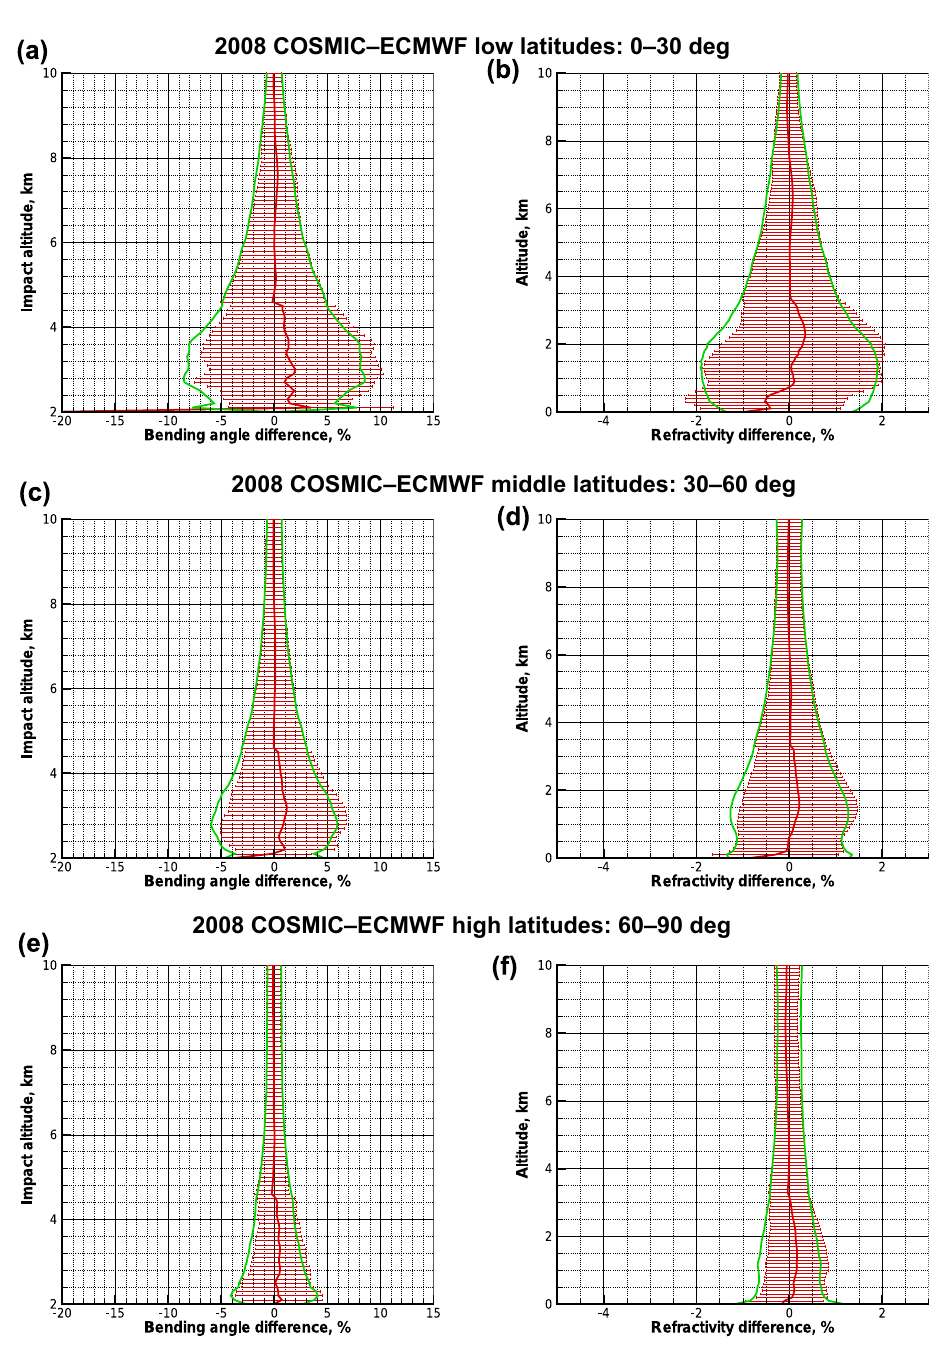
Figure 6. Deviation statistics based on original BLB-corrected bending angles: difference statistics of COSMIC profiles relative to ECMWF reference profiles, with the same layout of panels as for Fig. 2, for bending angle as function of impact altitude (a, c, e) and refractivity as function of altitude (b, d, f) . Results for low latitudes (a, b) , midlatitudes (c, d) , and high latitudes (e, f) are shown, based on COSMIC data from the 17th day of every month of year 2008 and concurrent ECMWF analysis